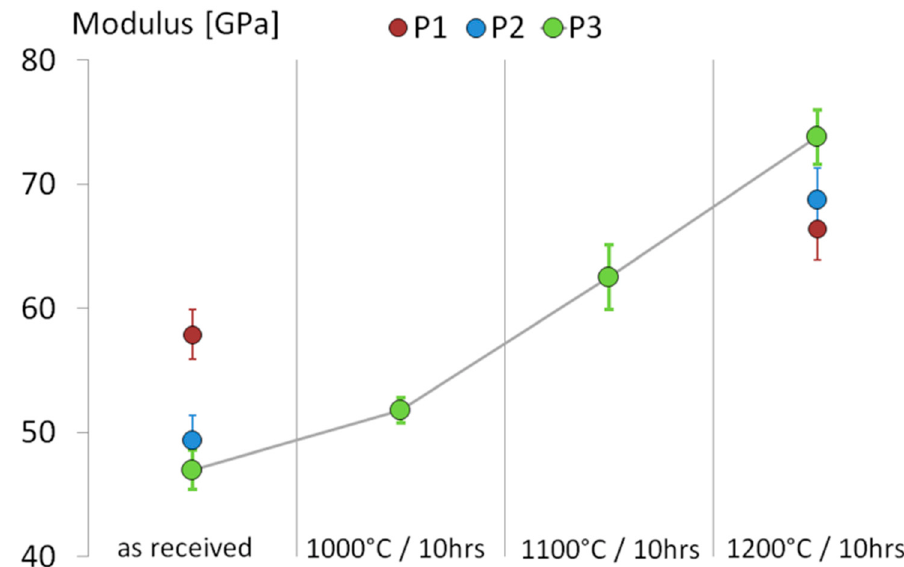
Figure 4. Young’s modulus for different aging conditions.